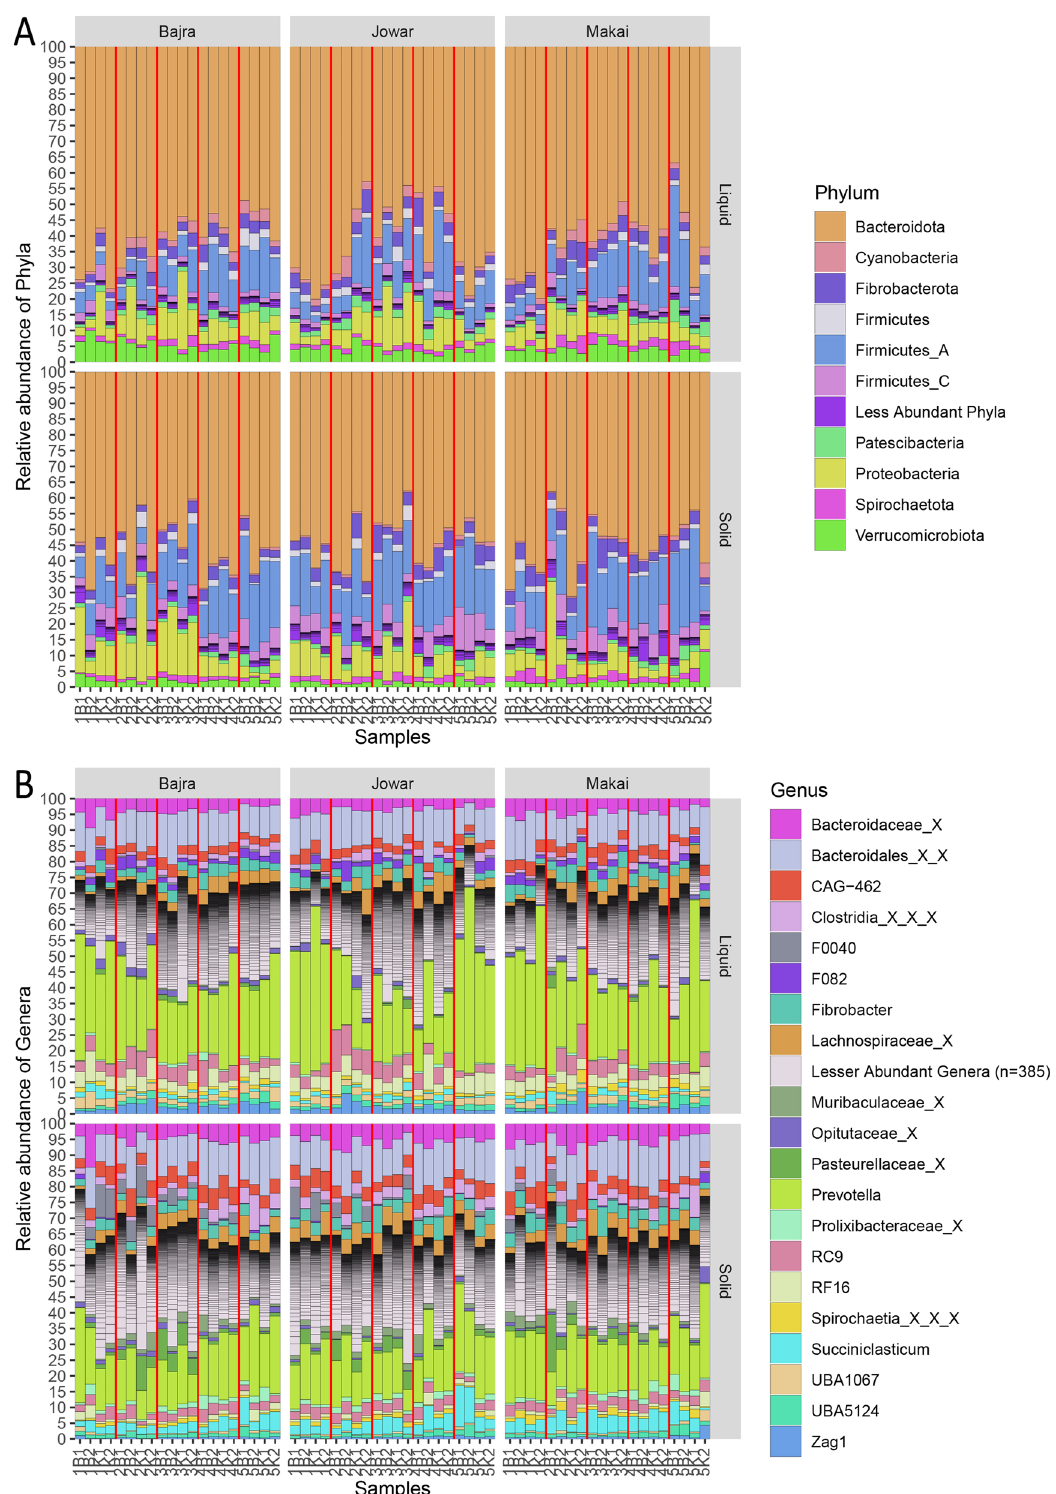
Figure 3. Bar plots showing diversity at ( A ). Phylum and ( B ). Genus level taxonomy. The samples are named and ordered as per Collection, Breed and animal number. Red vertical line differentiates different